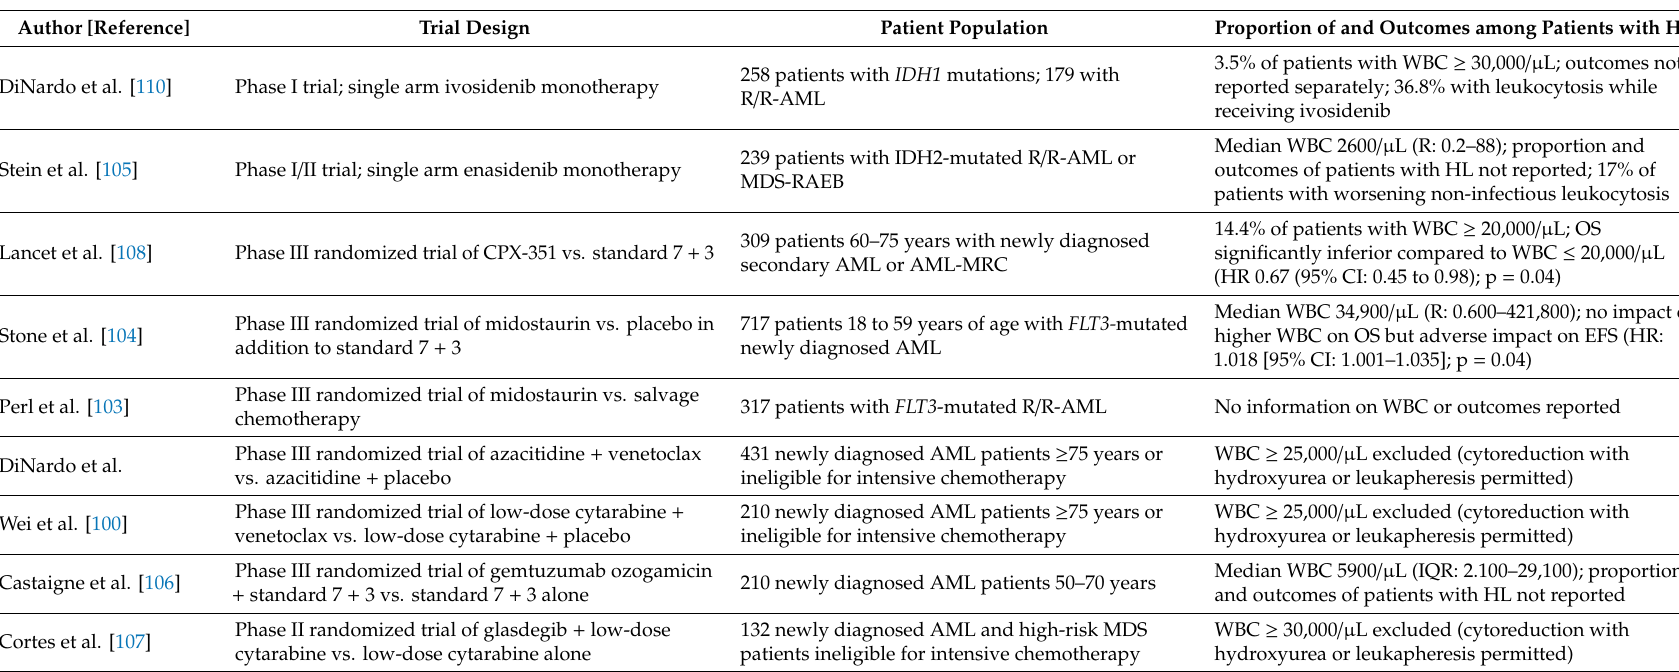
Table 2. Overview of recent randomized trials leading to the approval of novel agents and results regarding patients with